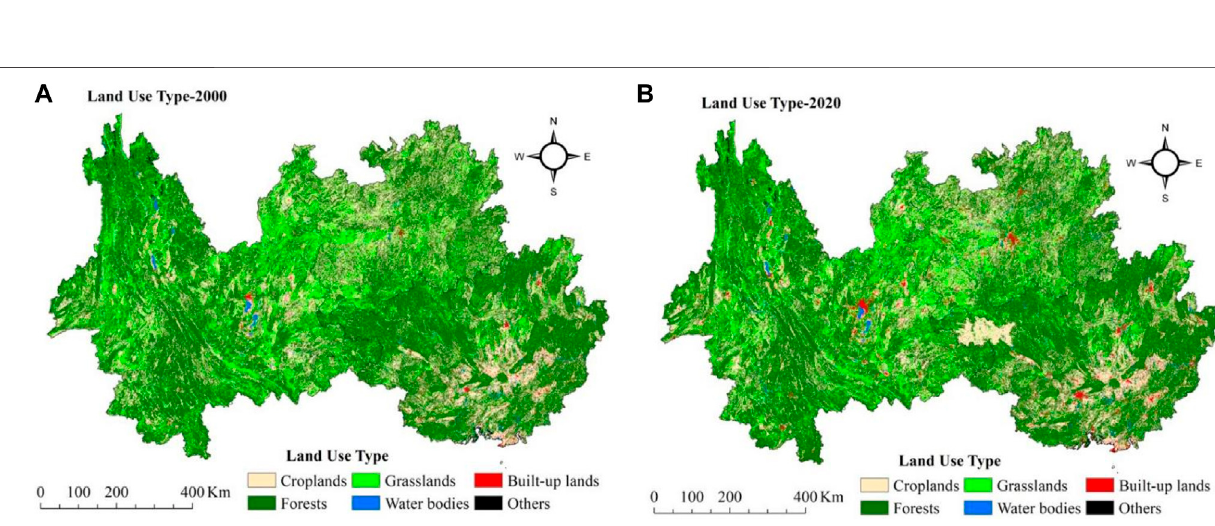
Frontiers in Earth Science |